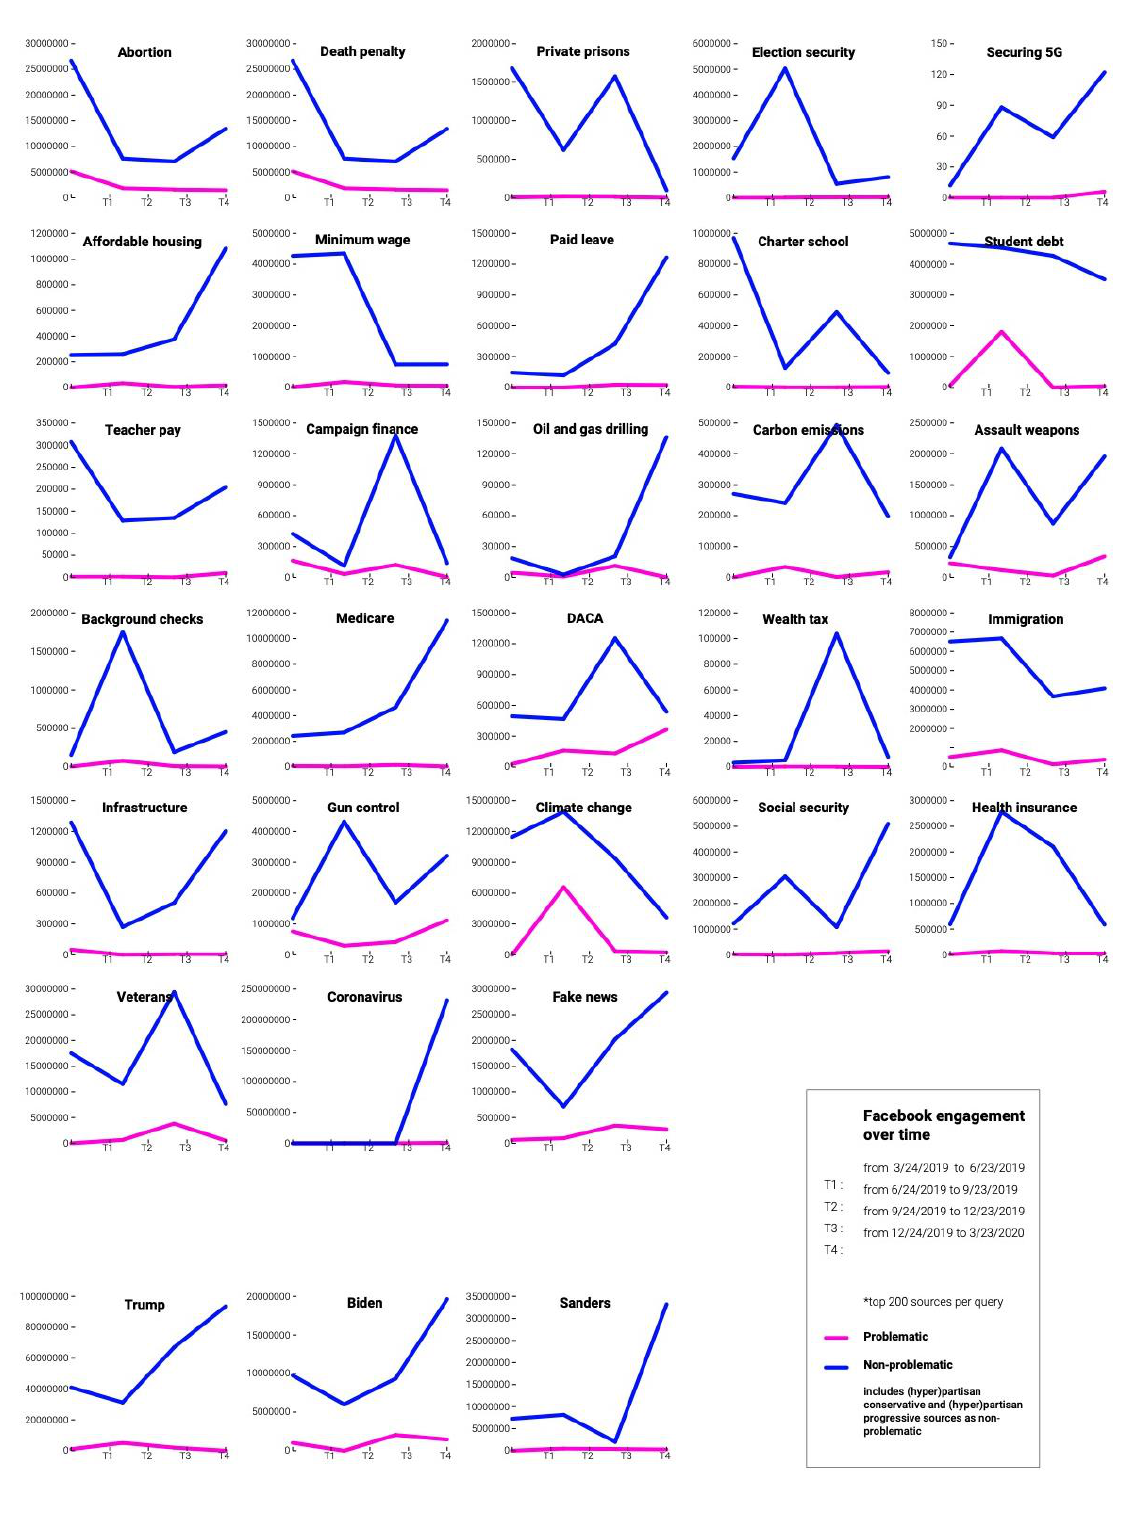
Figure 7. Facebook engagement scores of ‘fake news’ (narrow definition) versus mainstre am news for political candidate and social issue queries, March 2019 - March 2020. Absolute numbers shown for the sake of trend comparison. Source: